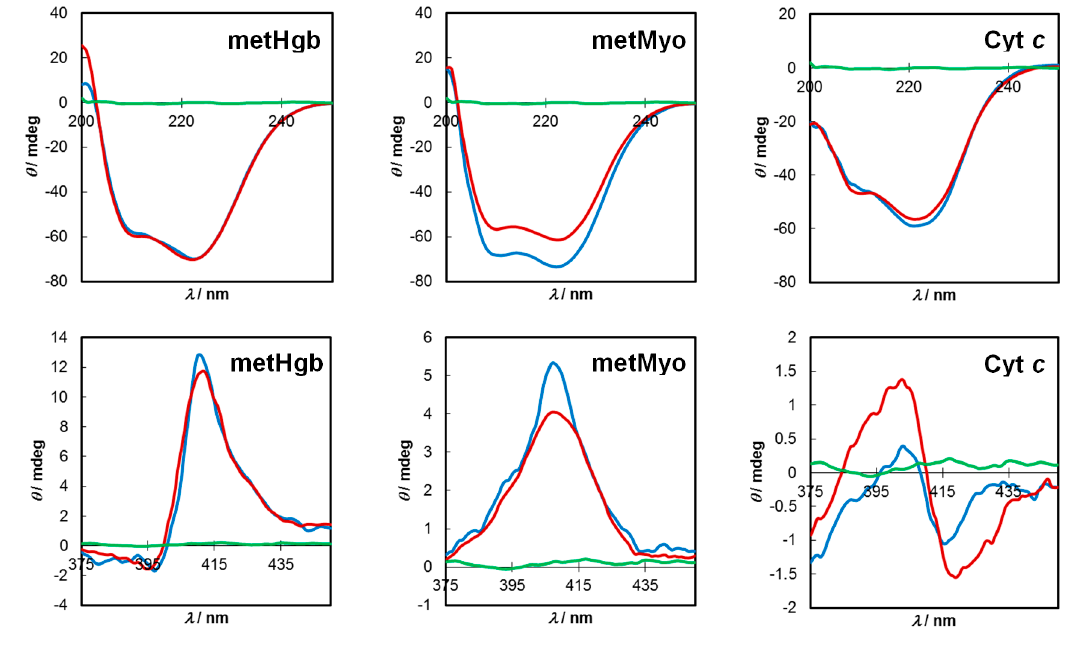
Figure 6. Circular dichroism spectra of proteins (red line), C-dots–protein complex (blue line) and C-dots (green line) in the far-UV (upper panel) and Soret (lower panel) regions at pH = 7.2.